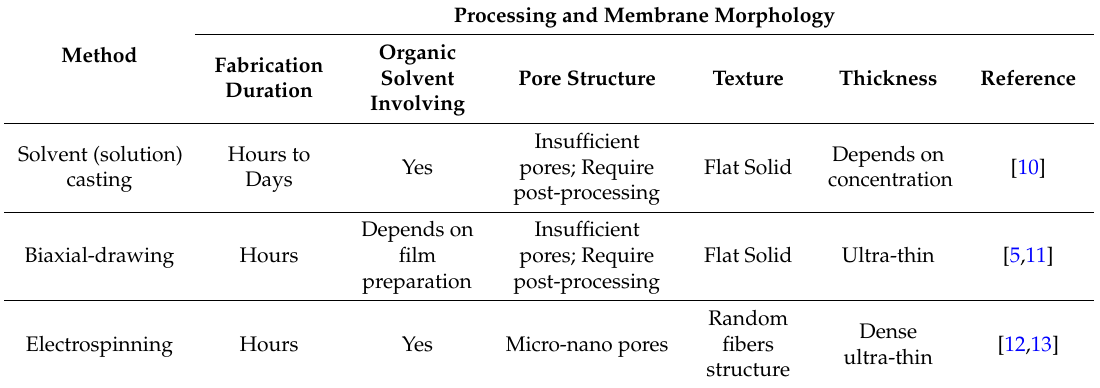
Table 1. Summary of membrane fabrication processes and